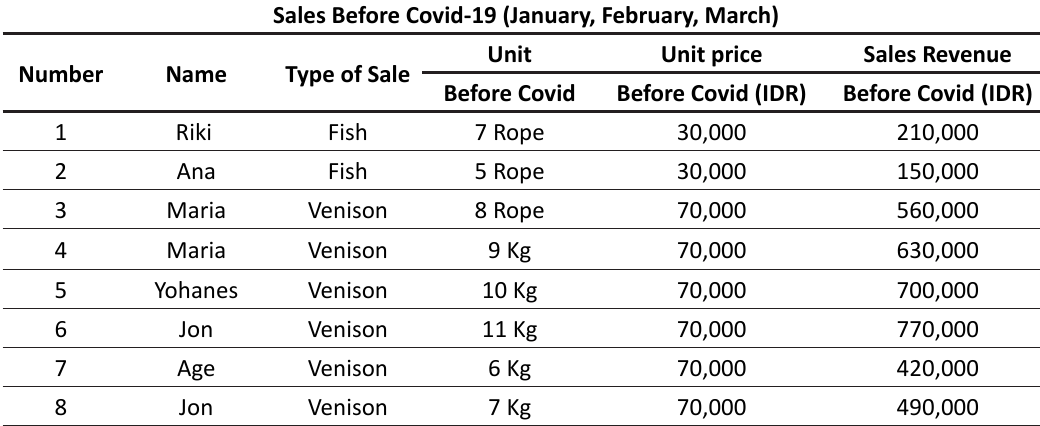
Table 2: Revenue from Sales Before Covid-19 at Mopah Market Sales Before Covid-19 (January, February,